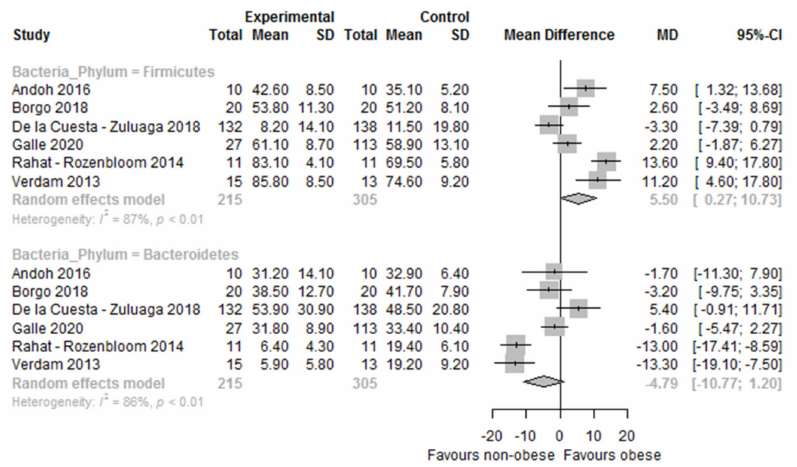
Figure 6. Forest plot of the differences in the gut microbiome composition at phylum level be- tween obese and non-obese. Study references: Andoh et al. [17], Borgo et al. [18], De la Cuesta— Zuluaga et al. [41], Gall è et al. [45], Rahat—Rozenbloom et al. [53], and Verdam et al. [56].